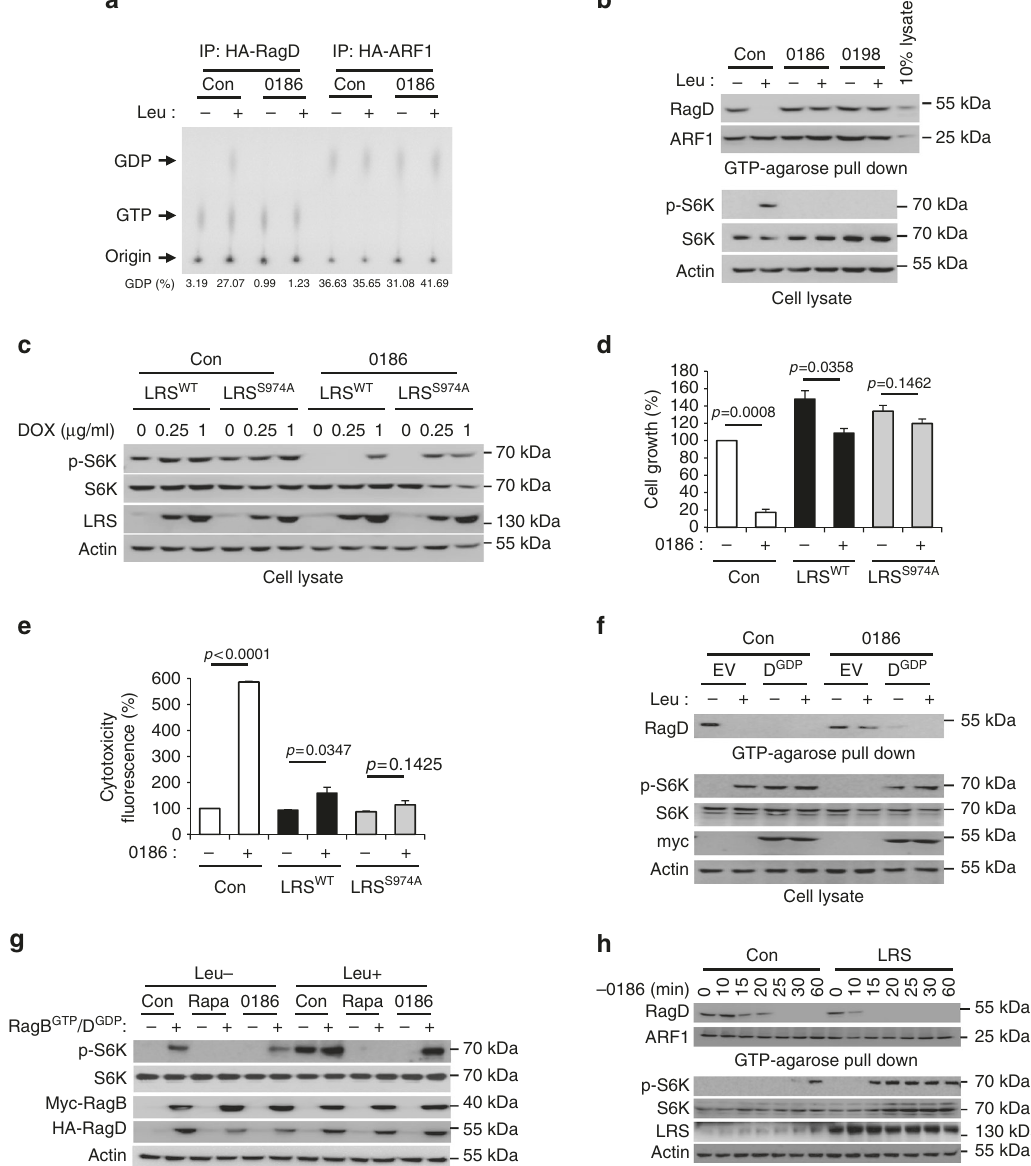
Fig. 4 Chemical validation of LRS role in the control of RagD GTPase and mTORC1. a HA-RagD WT or HA-ARF1 was transfected into SW620 cells. After 24 h, the cells were incubated with 100 μ Ci/ml 32 P-orthophosphate for 8 h, starved for leucine for 90 min, and then re-stimulated with leucine for 10 min. Cells were treated with 10 μ M BC-LI-0186 during leucine starvation and re-stimulation. HA-RagD or HA-ARF1 was immunoprecipitated with anti-HA antibody and the bound nucleotides were eluted and analyzed by TLC. GDP% means GDP/(GDP+ GTP) × 100. b Effect of BC-LI-0186 and BC-LI-0198 on the leucine-induced change of GTP hydrolysis of RagD. GTP-agarose bead pull-down assays were used to monitor the GTP-bound RagD or ARF1. After cells were treated with 10 μ M BC-LI-0186 for 1 h, cell lysates were pulled down with GTP-agarose beads and the precipitated proteins with the beads were analyzed by immunoblotting with anti-RagD and anti-ARF1 antibodies. c Effect of LRS WT or S974A overexpression on S6K phosphorylation inhibited by BC-LI-0186. Inducible LRS WT or S974A-overexpressed SW620 cells were treated with 10 μ M BC-LI-0186 for 1 h. Cell lysates were analyzed by immunoblotting with anti-p-S6K (T389), anti-S6K, anti-LRS, and anti-actin antibodies. d Effect of LRS WT or S974A overexpression on BC-LI-0186-induced growth inhibition ( d ) and cell death ( e ) (see Supplementary Fig. 5a). The data in Supplementary Fig. 5a were quanti fi ed and displayed as bar graphs. The error bars represent mean ± S.D. ( n = 3). f Effect of RagD GDP on the BC-LI-0186-dependent inhibition of GTP hydrolysis of RagD and S6K phosphorylation. SW620 cells were transfected with GDP mutant of RagD (S77L) and then starved for leucine for 1 h and re-stimulated with leucine for 10 min in the presence or absence of 10 μ M BC-LI-0186. Cell lysates were pulled down with GTP-agarose beads and the precipitated proteins with the beads were analyzed by immunoblotting with anti-RagD antibody. g Effect of RagB GTP /RagD GDP on rapamycin or BC-LI-0186-dependent inhibition of S6K phosphorylation. SW620 cells were co-transfected with GDP mutant of RagD (S77L) and GTP mutant of RagB (Q99L) and then starved for leucine for 1 h and re-stimulated with leucine for 10 min in the presence or absence of 10 μ M BC-LI-0186. h Effect of LRS overexpression on the kinetic changes of RagD and S6K phosphorylation that was arrested by BC-LI-0186 pretreatment. SW620 cells were treated with 10 μ M BC-LI-0186 for 1 h. Then, cells were incubated with BC-LI-0186-free media for the indicated times. Cell lysates were pulled down with GTP-agarose beads and the precipitated proteins with the beads were analyzed by immunoblotting with anti-RagD or ARF1 antibodies ( upper ). Cell lysates were analyzed by immunoblotting with their speci fi c antibodies ( lower ). The error bars represent mean ± S.D. ( n =